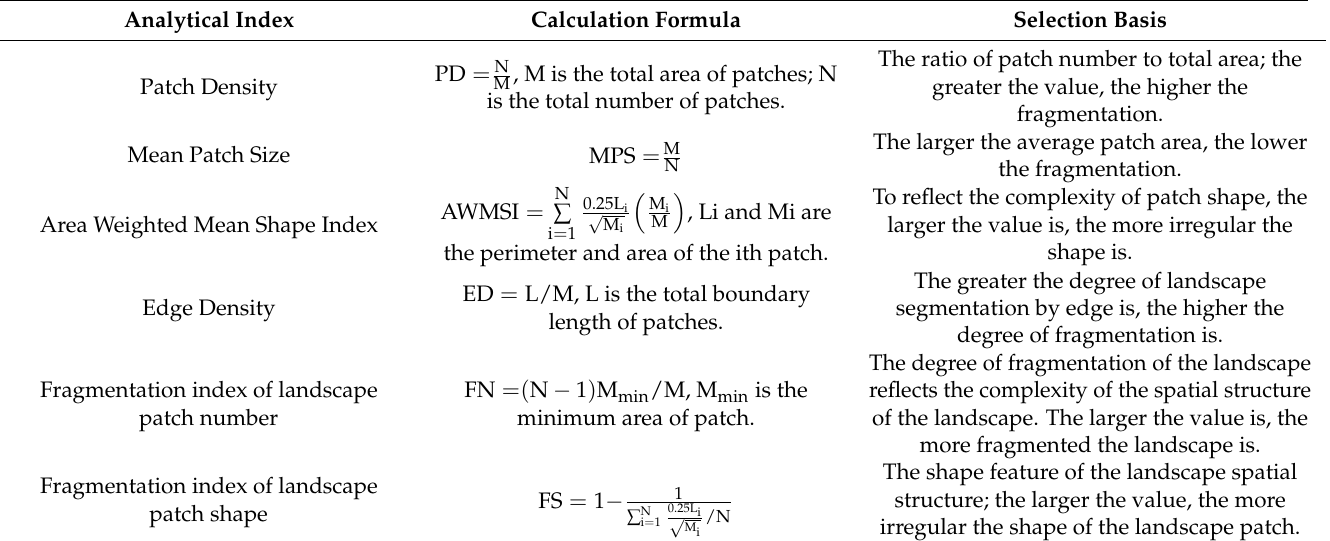
Table 1. Fragmentation/integration strength